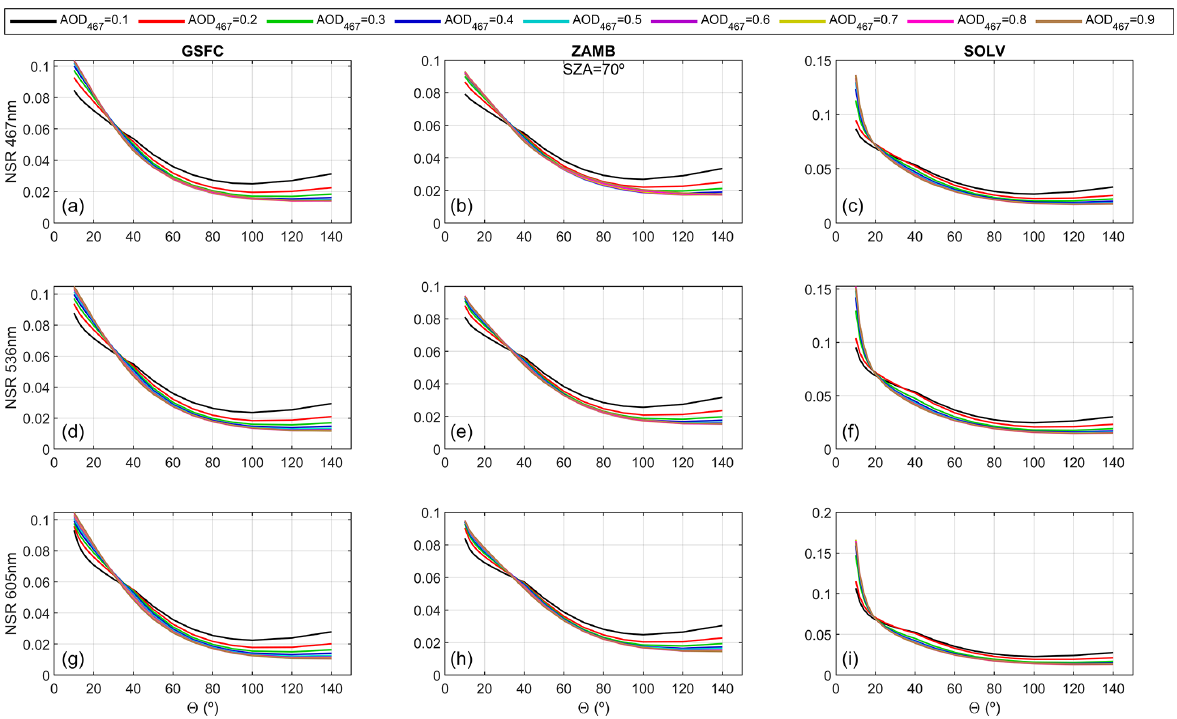
Figure 2. Normalized sky radiance (NSR) for solar zenith angle (SZA) of 70 ◦ at 467nm (a, b, c) , 536nm (d, e, f) and 605nm (g, h, i) as a function of scattering angle ( (cid:50) ) for different AOD (at 467nm) values. Columns correspond to (a, d, g) GSFC, (b, e, h) ZAMB and (c, f, i) SOLV aerosol